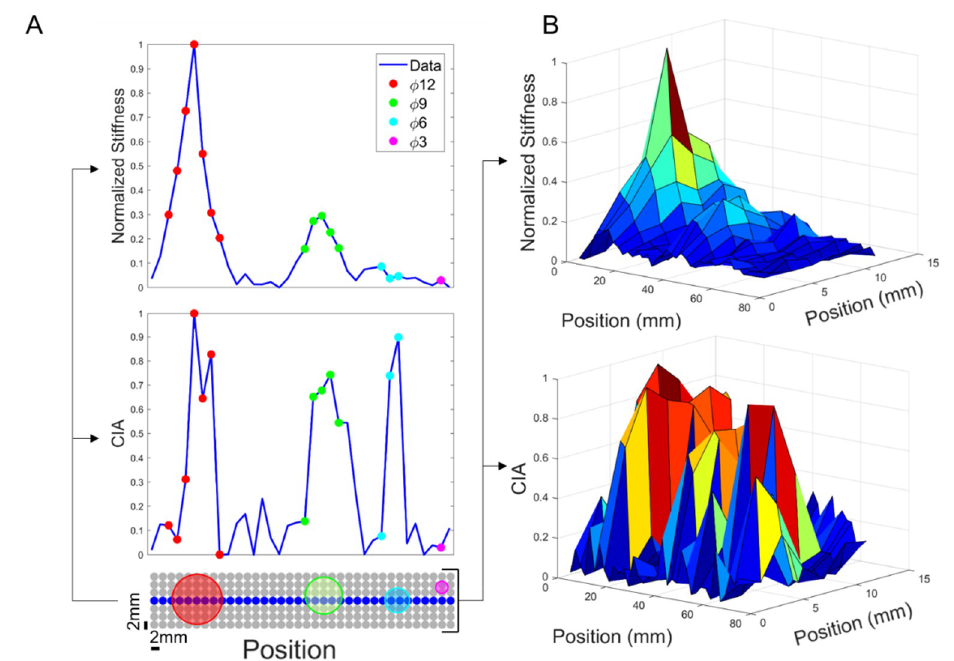
Figure 6. ( A ) ( top ) graph showing stiffness as a function of position, calculated as ΔFz/ΔZ, for the central row; ( bottom ) graph showing ultrasound signal processing of CIA index. ( B ) ( top ) 3D graph showing stiffness across the whole indentation matrix; ( bottom ) 3D graph showing ultrasound signal processing of Correlation Index Amplitude (CIA) index.